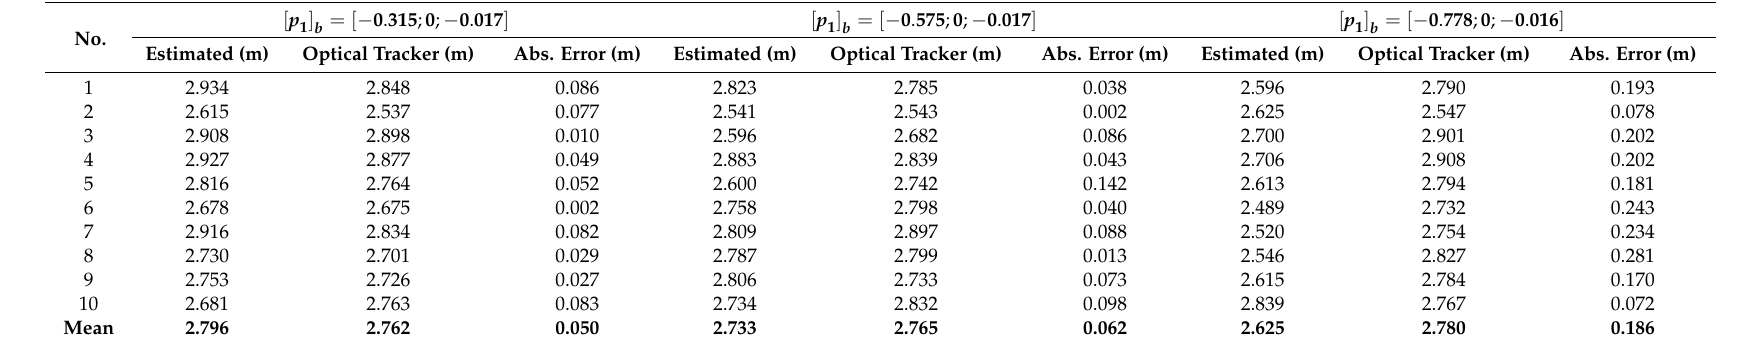
Table 2. Standard cane’s estimated and reference walking distance.